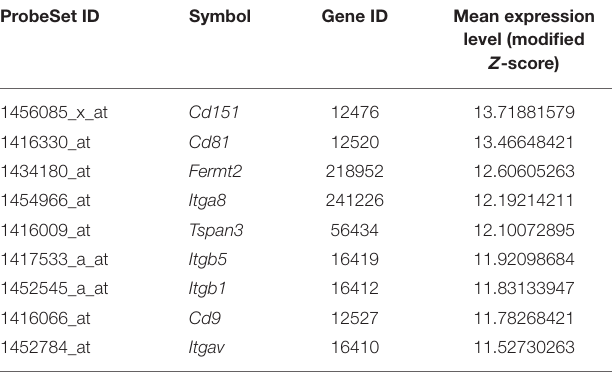
TABLE 1 | Mouse integrins, tetraspanins, and integrin-associated proteins with the gene expression levels that are significantly higher than the median expression level of all genes in mouse